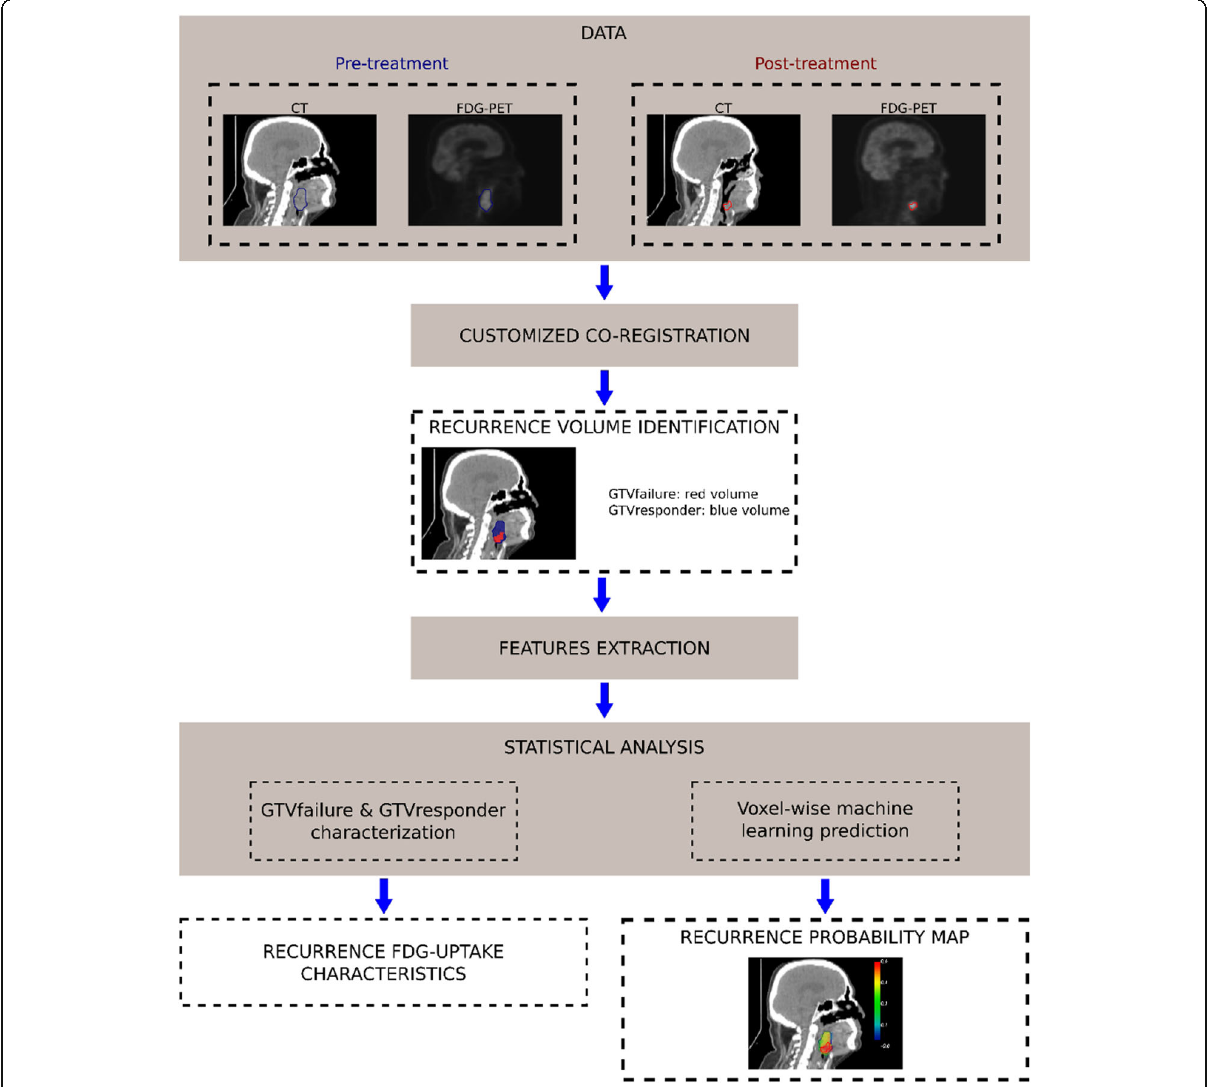
Fig. 1 Workflow of the study. (i) Intra-individual registration of post-treatment data to the pre-treatment space allows the definition of both the region of recurrence volume (GTVfailure) and the responder volume (GTVresponder). This step is followed by (ii) a regional analysis allowing to characterize the recurrence and (iii) a voxel-wise analysis (feature extraction and classification) which yields a probability map of